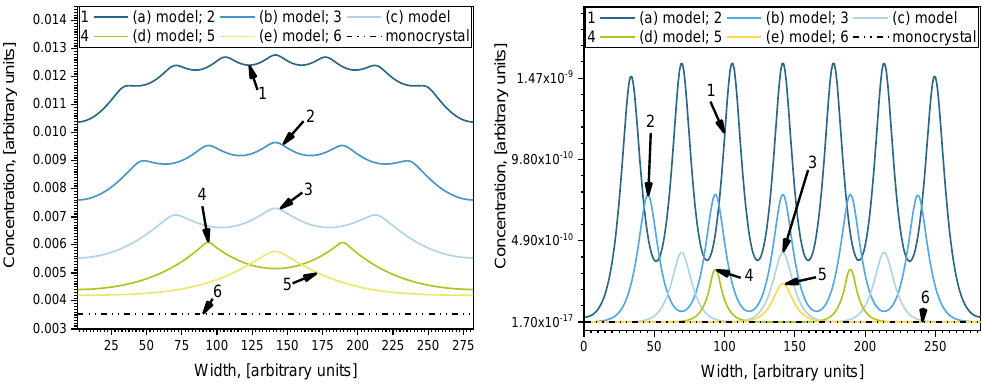
Figure 4. Parallel to the surface concentration profiles for different models at position i = 141 a.u.: at left side for Case 1 and at right side for Case 2.